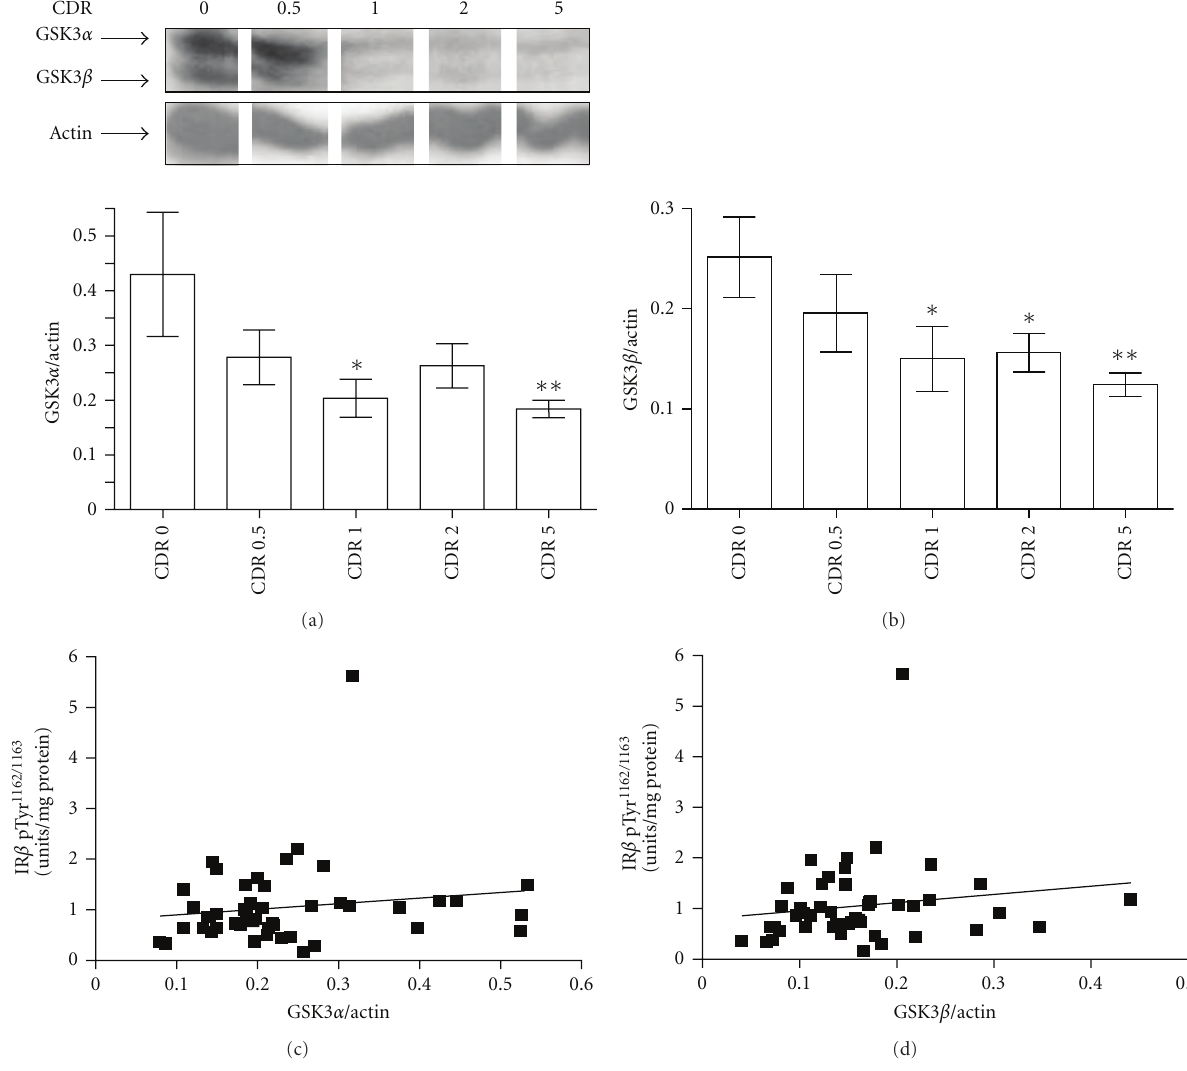
Figure 5: Reduced contents of total GSK3 α and GSK3 β in the hippocampal formation in AD brain specimens are not correlated with [Tyr1162/1163]-phosphorylated IR β . Total GSK3 α and GSK3 β contents in the hippocampal formation were assessed by Western blot analysis. In ((a) and (b)), bar graphs represent mean ± SEM total GSK3 α (a) and total GSK3 β (b) contents (nonphosphorylated and phosphorylated GSK3 α / β ) in the hippocampal formation relative to β -actin as a function of Clinical Dementia Rating. ANOVA; P = . 0111 and .0112, respectively, for GSK3 α and GSK3 β contents among CDR groups. One-tailed t -test in comparison to CDR 0: ∗ P < . 05; ∗∗ P < . 005. Inset: representative Western blot analysis of total GSK3 α and total GSK3 β from CDR 0, 0.5, 1, 2 and 5 hippocampal formation specimens. In ((c) and (d)), correlation analysis of GSK3 α (c) and GSK3 β (d) contents with respect to [Tyr1162/1163]-phosphorylated IR β contents in the hippocampal formation. Pearson correlation analysis; P = . 318 and .308 for GSK3 α and GSK3 β contents with contents of [Tyr1162/1163]- phosphorylated IR β ,